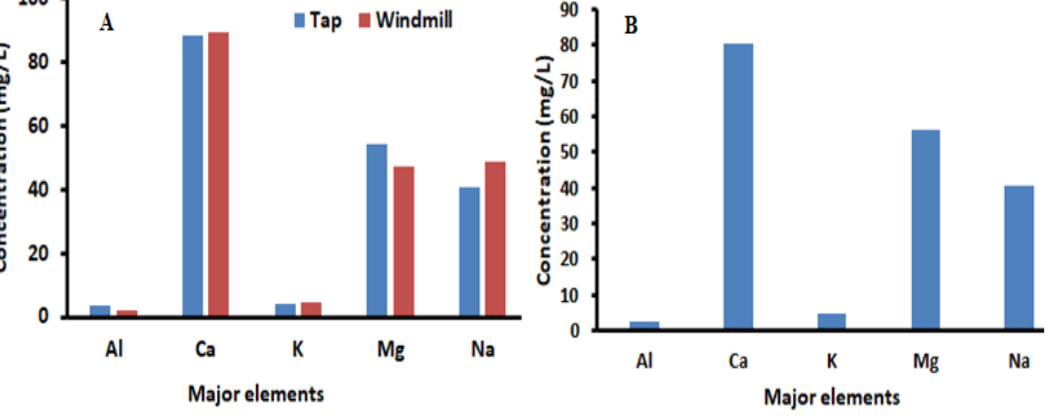
Figure 1. Metal concentrations (mg L −1 ) of major elements in drinking water collected during ( A ) dry and ( B ) wet